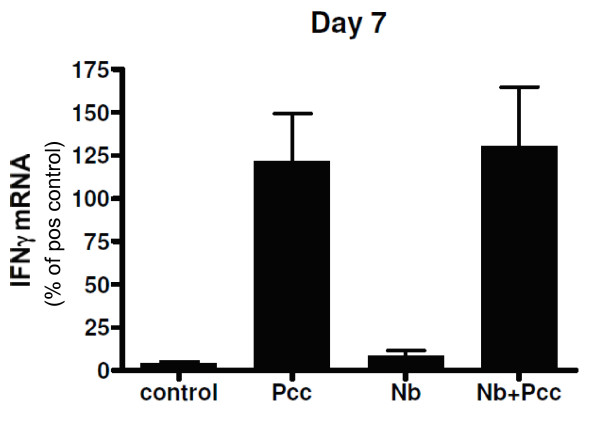
Lung mRNA for the Type 1 cytokine IFN-γ at 7 days pi. Real-time RT-PCR of mRNA from lung tissue harvested at 3, 5, 7 or 20 days pi using primers for Type 1 markers iNOS, IL-12p40, TNF-α, and IFN-γ were largely negative. For example, no iNOS nor IL-12p40 was detected in any mice, and although TNF-α was detected at low levels, its expression did not differ among groups of mice. At 7 days pi, however, IFN-γ was significantly upregulated in all mice with Pcc infection, with or without Nb co-infection, as depicted here. Data are expressed as percentage of a positive control sample (peritoneal macrophages of a thioglycolate-injected mouse [10]). Mean ± SEM from a representative experiment with 4-9 mice per group per timepoint are shown.